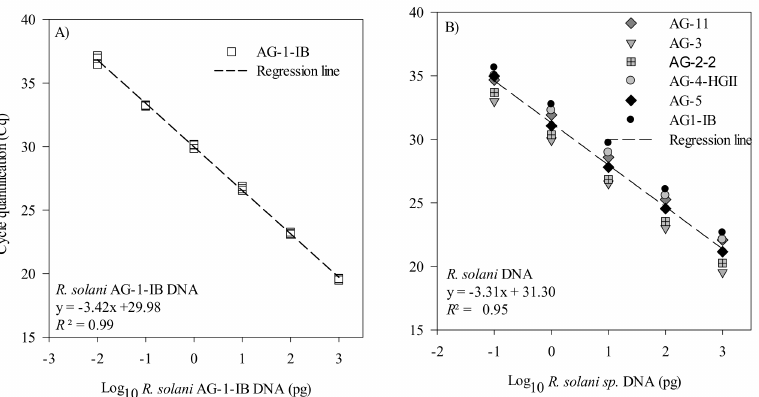
Figure 2. Standard curves and regression of Rhizoctonia solani AG 1-IB and R. solani dilution series measured by qPCR. The cycle quantification threshold (Cq) is plotted against the log 10 of ( A ) the picogram of R. solani AG 1-IB DNA belonging to several isolates. The results are from three inde- pendent experiments and ( B ) the picogram of R. solani DNA from isolates belonging to the AG1-IB, AG2-2, AG3, AG4-HGII, AG5, and AG11 groups. Cq values for these experiments are provided in Supplementary Tables S1 and S2.